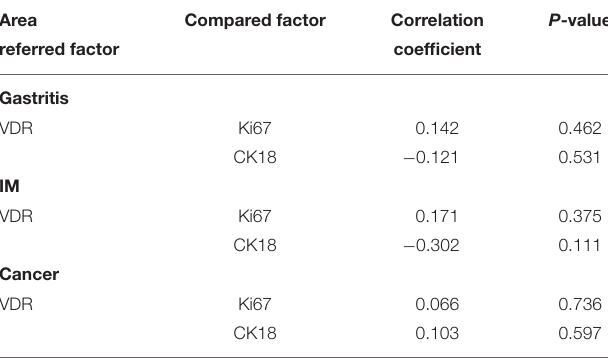
TABLE 4 | Correlation the expressions between VDR and Ki67 or CK18 in different sites. Area Compared factor Correlation P -value referred